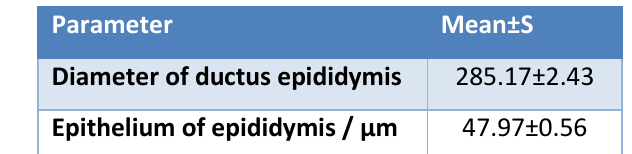
Table, 1: Showing the diameter of ductus epididymis µm and height of epithelium of ductus epididymis µm